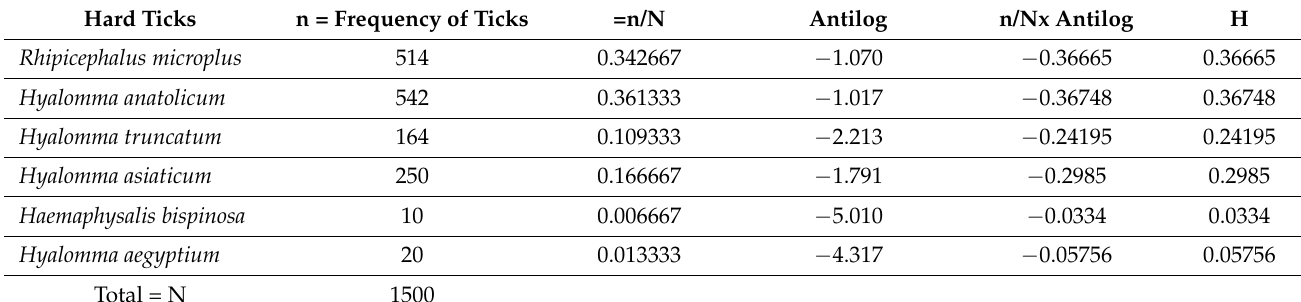
Table 6. Shannon–Weiner diversity index of tick species.